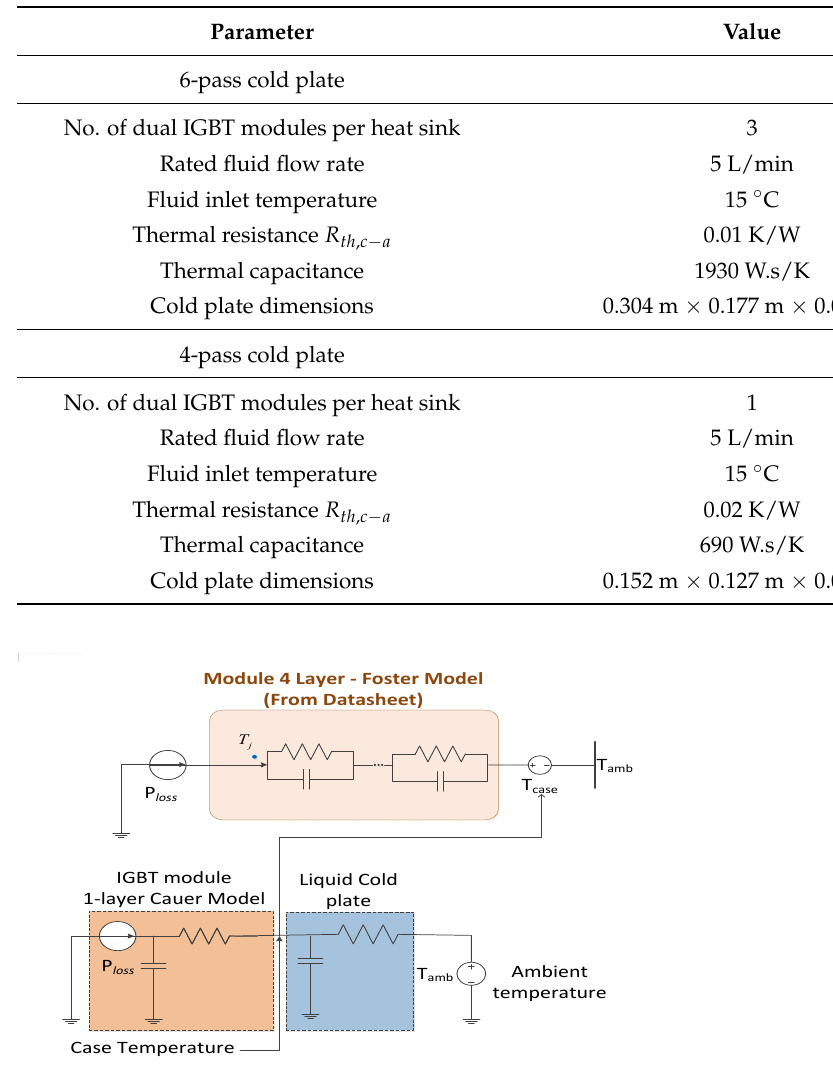
Figure 12. Three phase modules of the generator side converter mounted on a single water cooled heat sink (6-pass cold plate from Wakefield-Vette). In the case of 4-pass cold plate, only one phase module is mounted on each cold plate. Table 4. Forced-water cooling parameters.